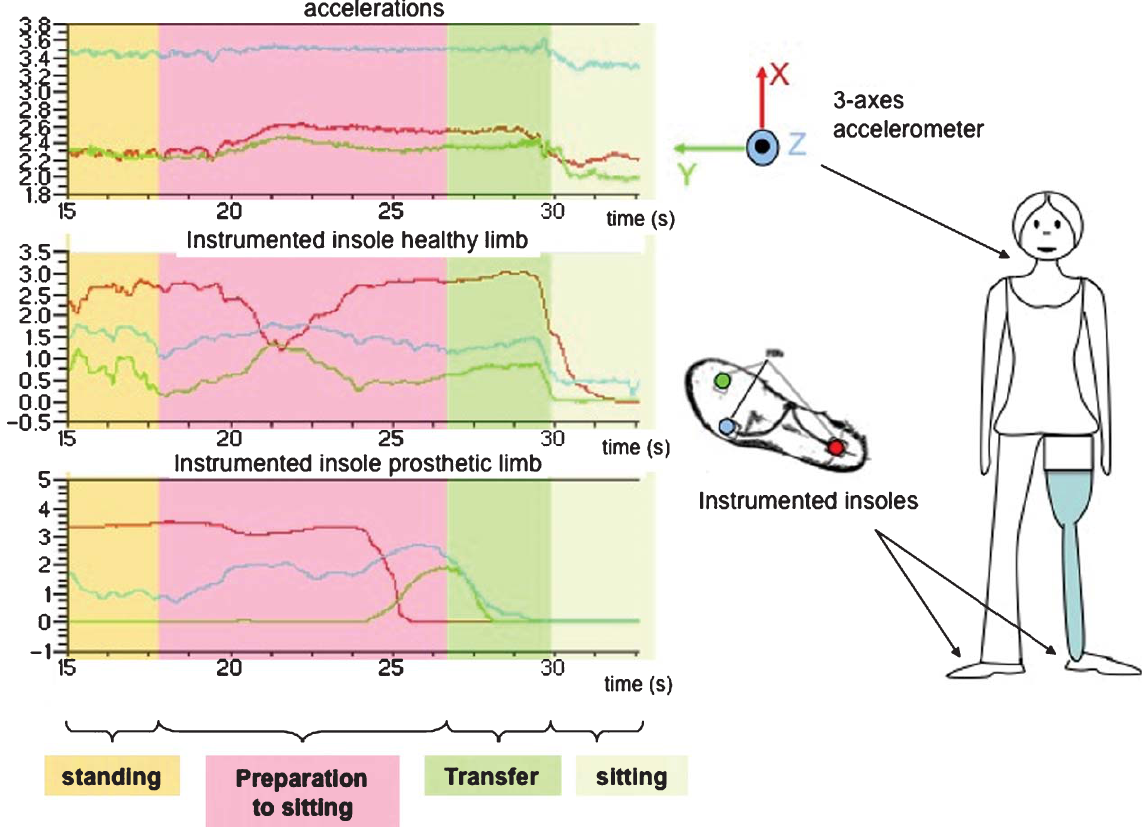
Fig. 5. Analysis of one amputee stand-to-sit transfer (1